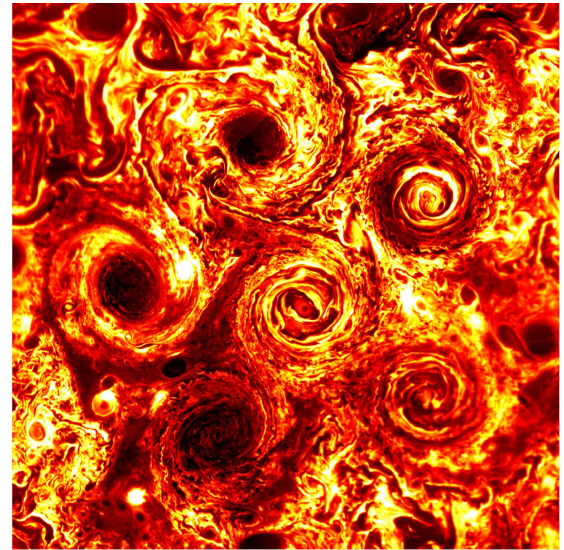
Figure 3. Six cyclones in Jupiter’s south polar region as revealed by a Juno/JIRAM image taken on February 2, 2017, at a wavelength of roughly 5 microns. Image Credit: NASA/JPL- Caltech/SwRI/ASI/INAF/JIRAM (NASA